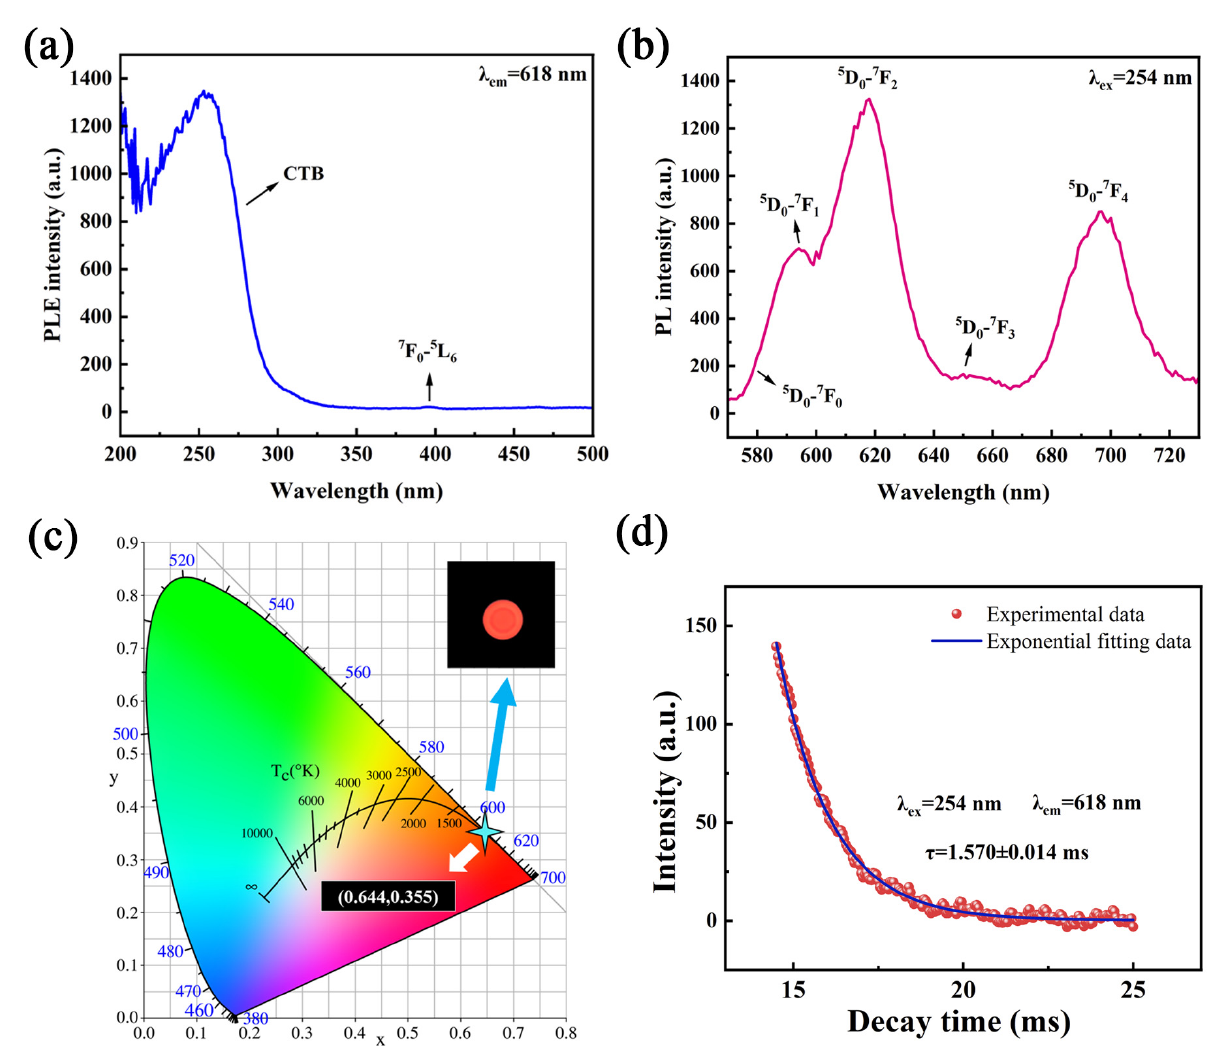
Figure 6. ( a ) PLE, ( b ) PL spectra, ( c ) CIE chromaticity diagram, and ( d ) fluorescence decay curve with fitting results of the ceramic film calcined at 1550 °C.